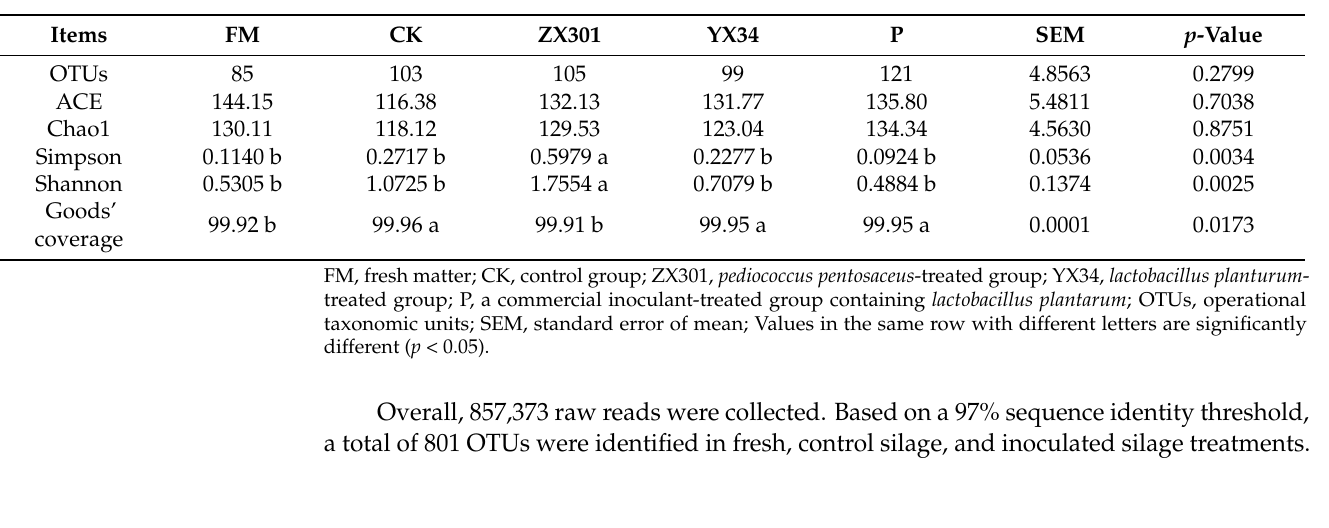
Table 6. Effects of additives on bacterial alpha diversity of Stipa grandis silage after 60